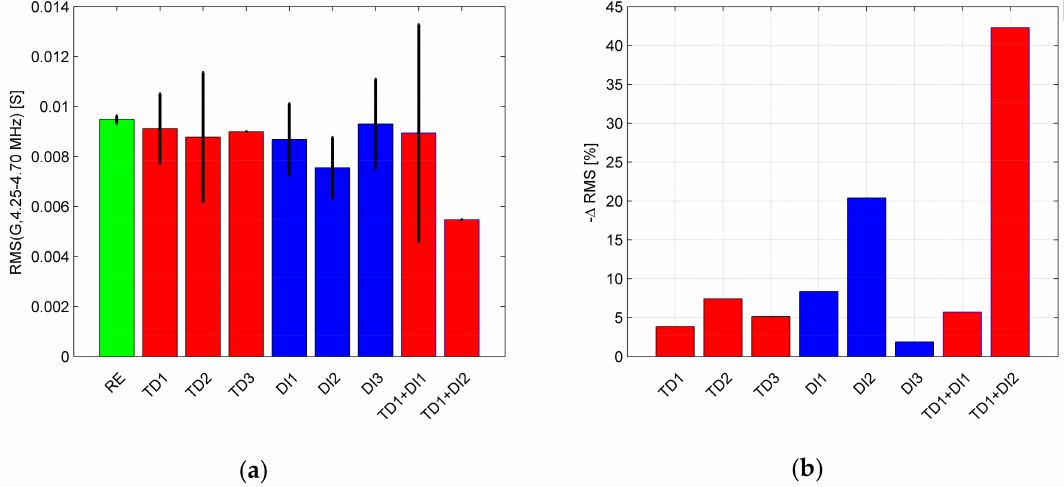
Figure 8. Results of investigating of the 4.25–4.70 MHz frequency region with RMS index: ( a ) calculated RMS values; ( b ) relative drop of the RMS values in relation to the results for the set of referential samples